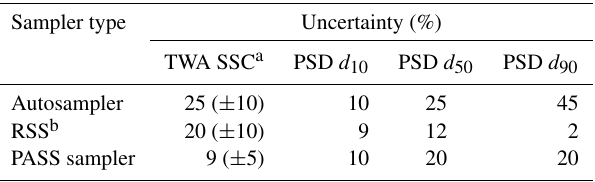
Table 1. Uncertainties, of either SSC or PSD measurements, associ- ated with suspended sediment monitoring methods used in alluvial gullies. Source: Doriean et al.